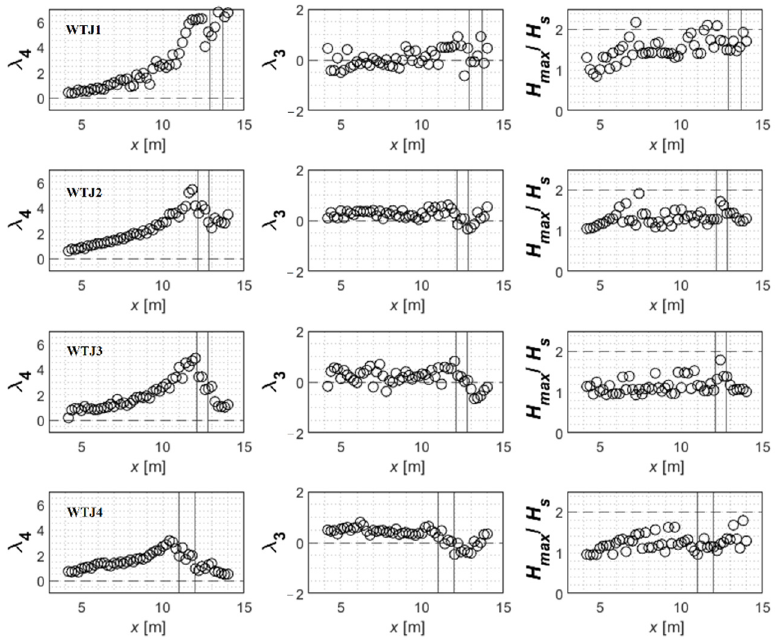
Figure 5. The spatial evolution of λ 4 , λ 3 and H max / H s for the four studied JONSWAP ( γ = 3.3) wave